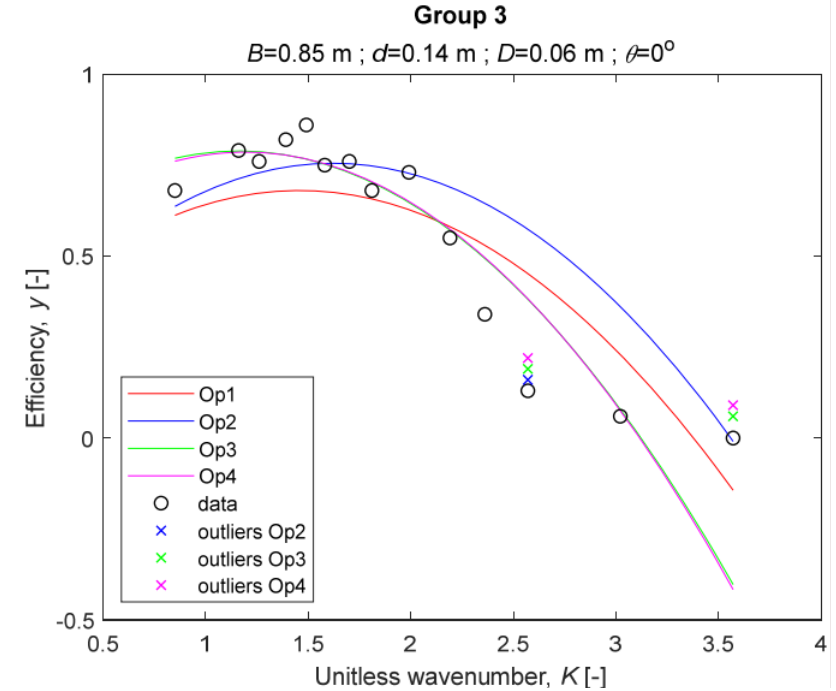
Figure 5. The four models for Group 3. The outliers for a model are denoted above the point with a cross in a respective color.